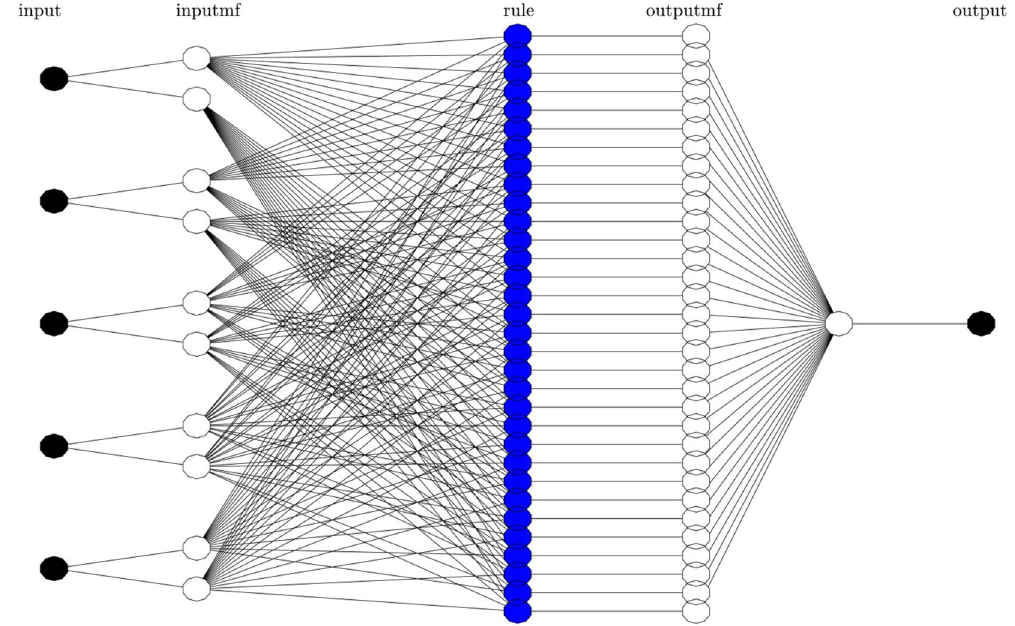
Figure 2. ANFIS structure with five inputs and two membership functions for each